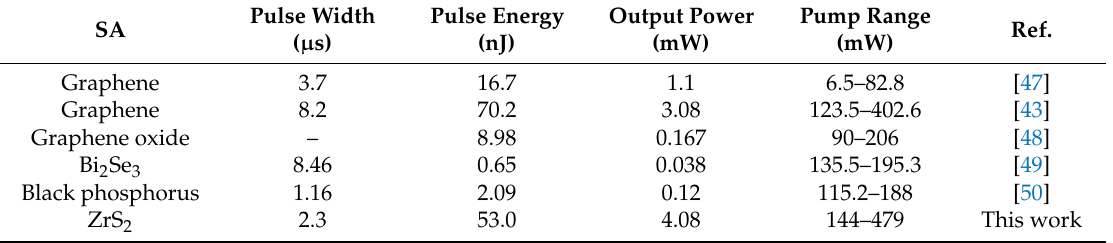
Table 1. Performance comparison of dual-wavelength Q-switched fiber lasers with 2D